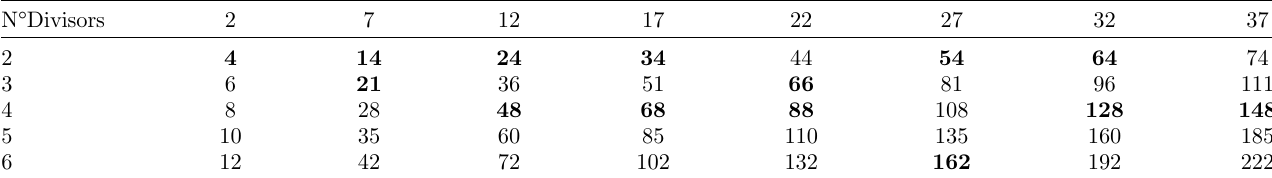
Table 12. Product of subtotals of Table 11 and number of